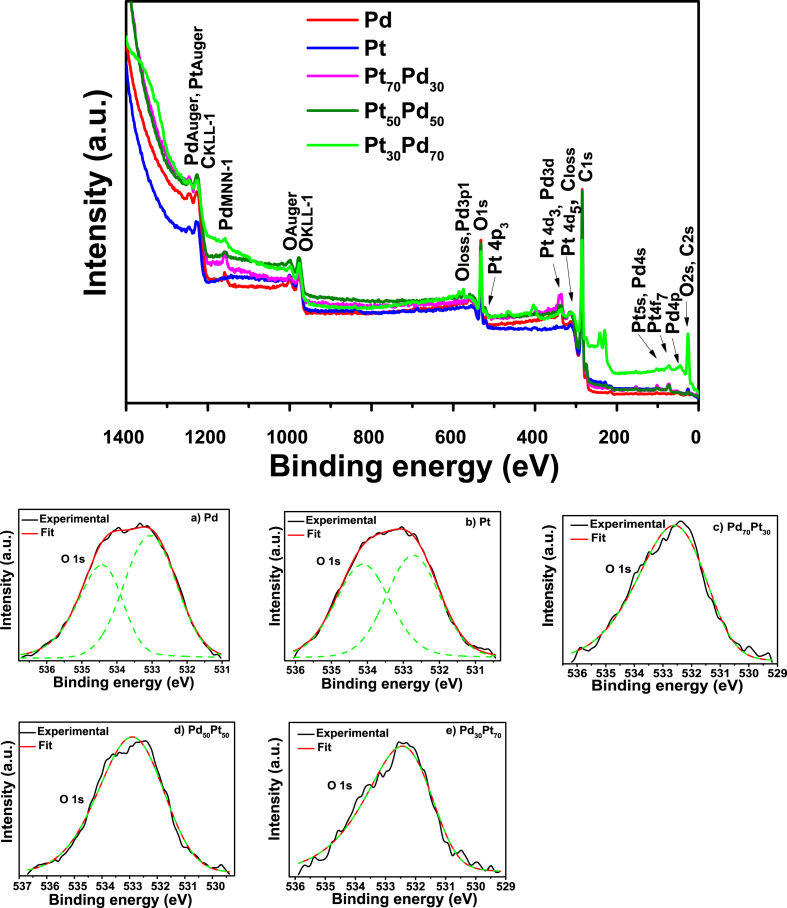
XPS Survey spectra of a) Pd, b) Pt, c) Pt30Pd70, d) Pt50Pd50 and e) Pt70Pd30 and deconvolution of O1s spectra.